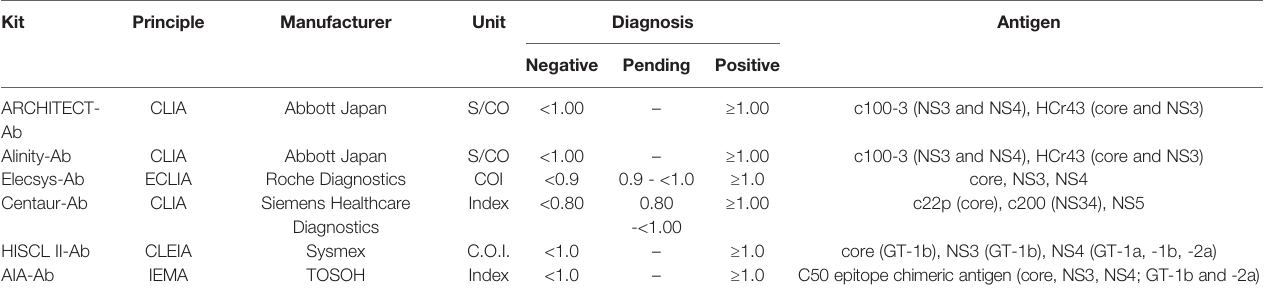
TABLE 2 | Anti-HCV detection kits not providing antibody titer classi fi